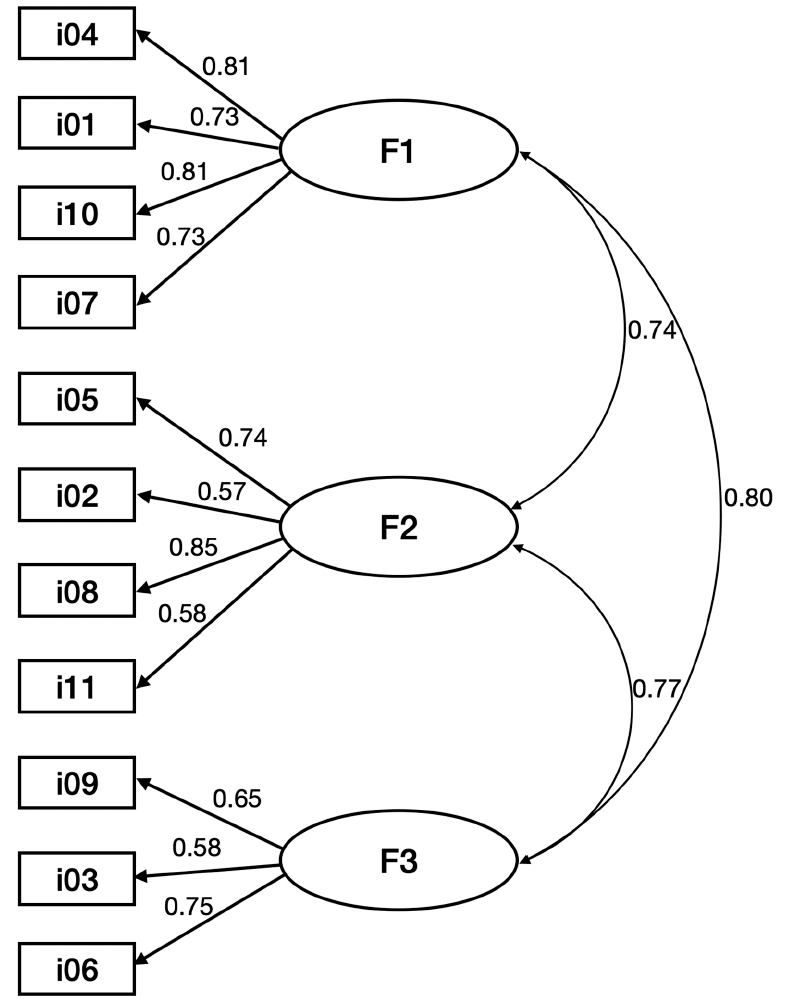
Figure 1. Path diagram with three-factor solution.